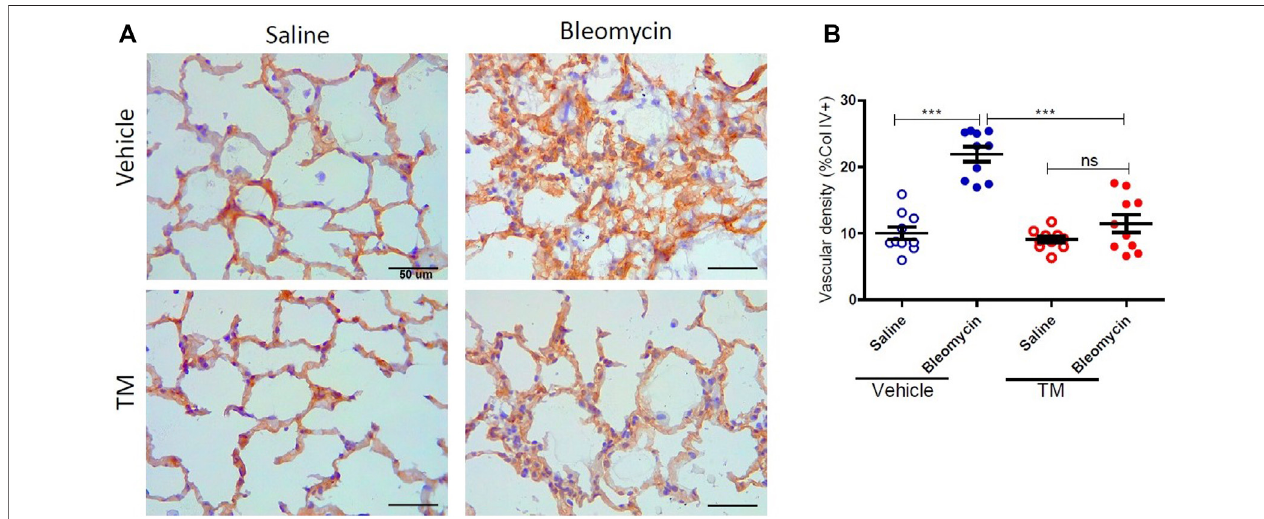
FIGURE 3 | Effects of tetrathiomolybdate on bleomycin-induced angiogenesis of collagen type IV positive capillaries. (A) Representative photomicrographs showing anti-type IV collagen immuno-stained lung tissue sections of saline and bleomycin-infused lung segments from either vehicle (sterile saline) or tetrathiomolybdate treated sheep. In each animal, one lung segment was infused with saline (left-side images) whereas the contralateral segment was infused with bleomycin (right-side images). (B) Shows the vascular density data of differentially treated lung tissue segments of either vehicle or tetrathiomolybdate treated animals. Signi fi cance was analyzed using a paired t -test between saline-vs bleomycin-infused segments from the same animals and an unpaired t -test between segments from different animals (vehicle vs . TM treated animals), *** p < 0.001, ns-not signi fi cant, ( n (cid:1) 10 Sheep). Data represent mean ( ± SEM). Scale bars (cid:1) 50 µm.